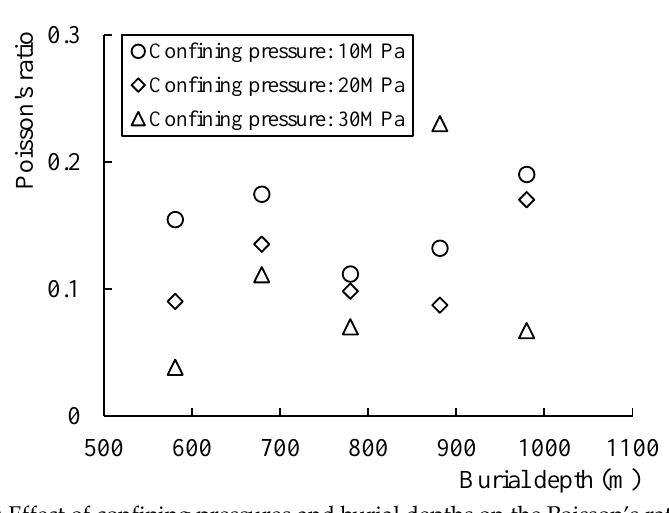
Figure 4. Effect of confining pressures and burial depths on the material response Figure 4. E ff ect of confining pressures and burial depths on the material